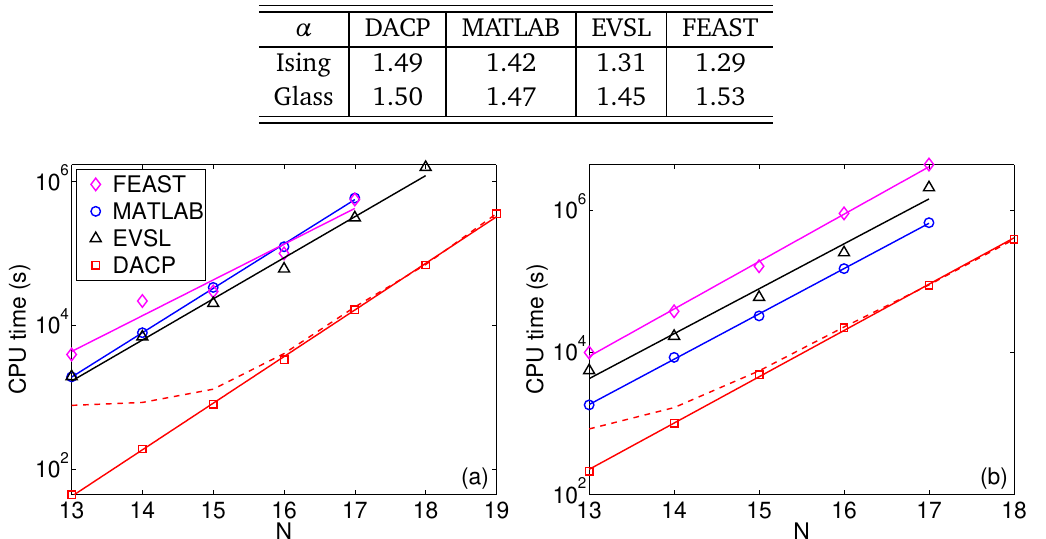
Table 1: Scaling constants α by linear fitting of the curves in Figure 6.